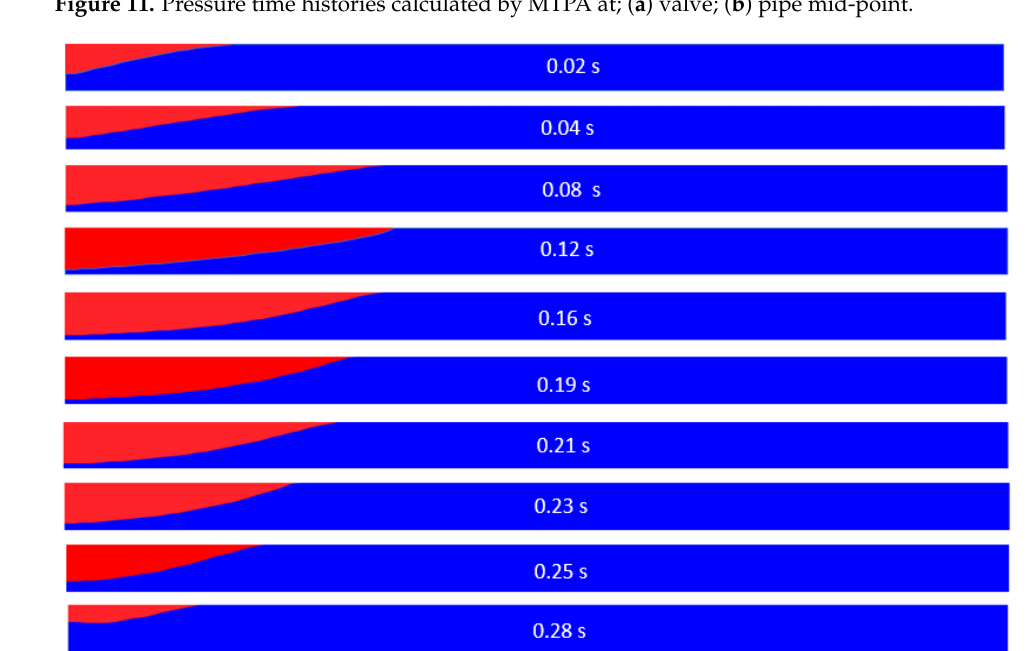
Figure 11. Pressure time histories calculated by MTPA at; ( a ) valve; ( b ) pipe mid-point.